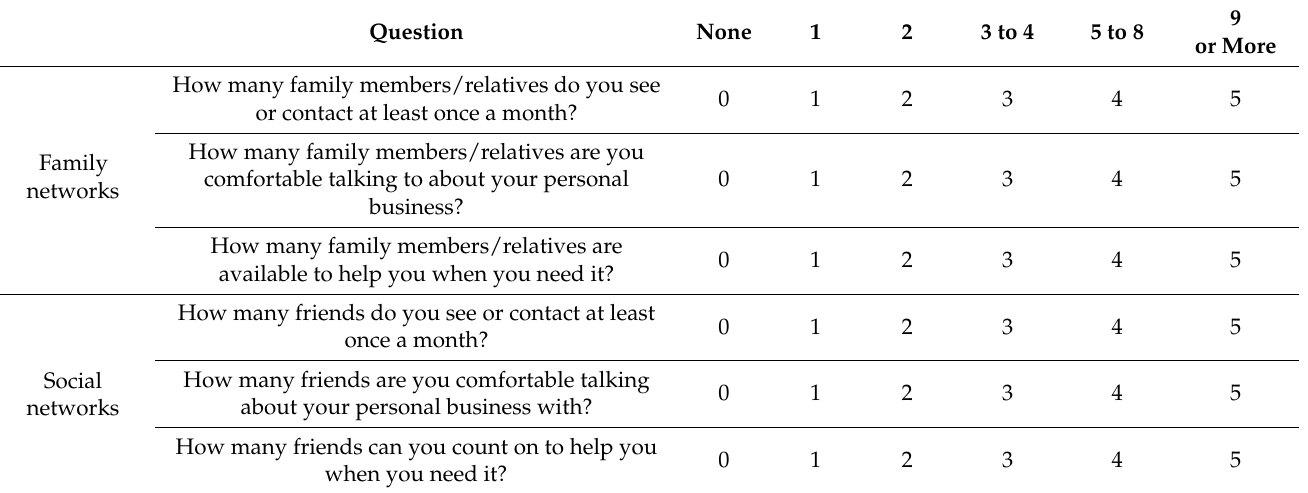
Table 2. Family Network and Social Network Scale